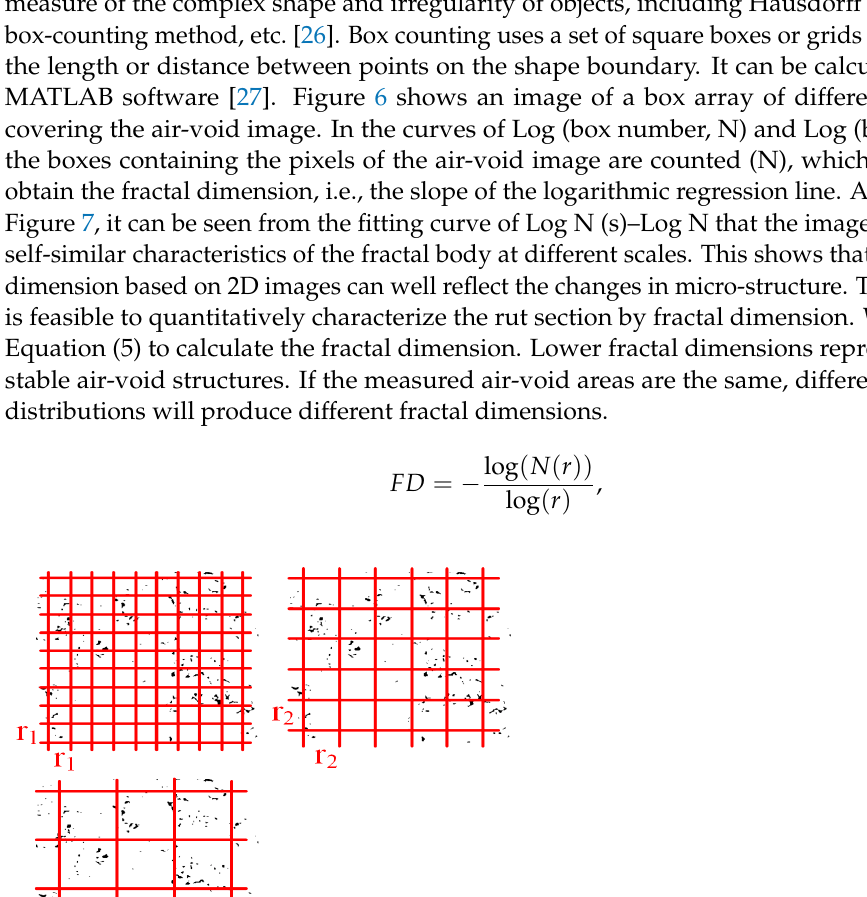
Figure 5. Shape features.